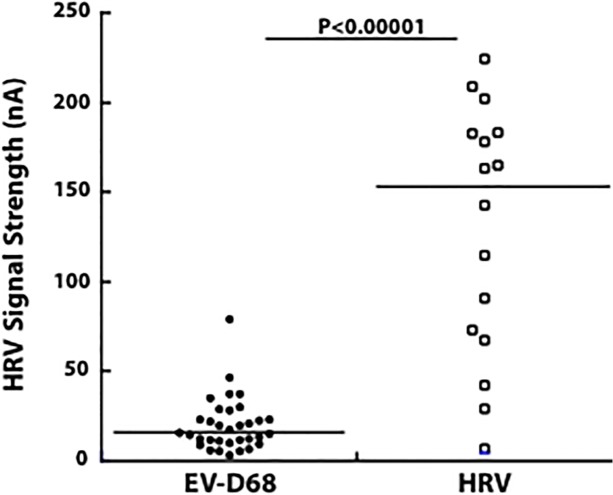
GenMark eSensor RVP signal strength for HRV in samples stratified by sequence results.Un-masking of the RVP results for all 62 samples revealed that the 49 positive PCR amplicons identified were derived from those samples that were also positive for HRV on the GenMark panel. Sequencing of these amplicons revealed that 33 were EV-D68 and 16 were HRV. The mean signal strength in nA of the RVP results for those samples identified as EV-D68 was significantly lower than for the HRV samples (20.3 nA versus 129.7 nA, respectively, p < 0.00001).